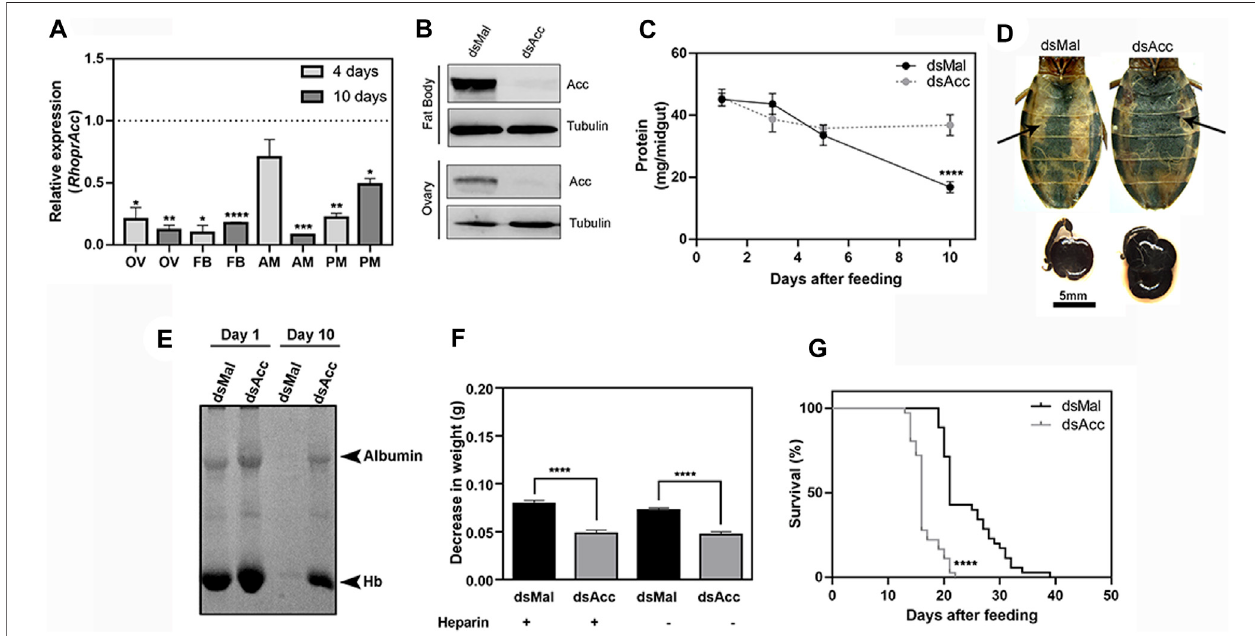
FIGURE1| Acc knockdowninadultfemalescompromiseddigestion andlifespan.Starving adultfemaleswereinjectedwith1 µgofdsRNAfor Acc or Mal (control) and werefed3 days later (A) Fourand 10 days afterblood meal,insectsweredissected,and Acc RNAlevels weredetermined byqPCR using Rhopr18S asareference geneinovaries(OV),fatbodies(FB),anteriormidguts(AM),andposteriormidguts(PM).Expressionlevelsarerelativetothosefromcontrolinsects(dashedline).Barsare means±SEMforn=3 – 5.(*),(**),(***),and(****): p < 0.05,0.01,0.001,and0.0001,respectively,byStudent ’ s t -test (B) ImmunoblottingsforACCidenti fi cationinfat bodiesandovaries ’ homogenates(60 – 70 µgprotein),obtainedatdayfourafterbloodmeal,representativeimages(n=4) (C) Atone,three, fi ve,and10 daysafterblood meal, insects were dissected and protein content was determined in total midguts. (****): p < 0.0001 by two-way ANOVA followed by Sidak ’ s post-test. Results are means ± SEM, n = 6. (D) Abdomens and midguts obtained from control and AccKD females, at 10 days after feeding. Arrows indicate the midguts. (E) The injected females were dissected at one and 10 days after blood meal, and the midgut protein content was analyzed by SDS-PAGE (12.5% polyacrylamide). Albumin and hemoglobin(Hb)bandsareindicated. (F) ThreedaysafterdsRNAinjection,insectswerearti fi ciallyfedonbloodsupplementedornot(control)withheparin.Femaleswere weighed at days one and ten, and the results are expressed as the observed decrease in weight during this time. (****): p < 0.0001 by one-way ANOVA followed by Tukey ’ s test, n = 9 – 15. (G) After blood meal, the insect mortality was daily recorded. (****): p < 0.0001 by Log-Rank test, n = 27 – 28.